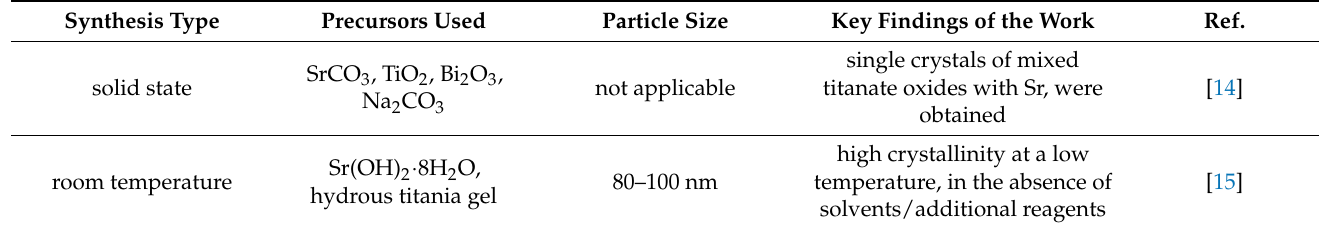
Table 1. Different synthesis methods used for the preparation of the SrTiO 3 nanoparticles. Synthesis Type Particle Size Key Findings of the Work